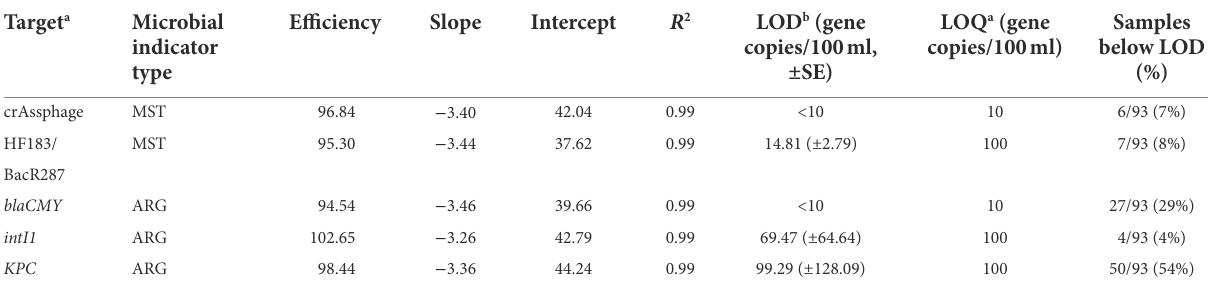
TABLE 1 Summary of standard curve material and performance for the microbial source tracking (MST) markers and antibiotic resistance- associated genes (ARGs) quantified in the study. Target a